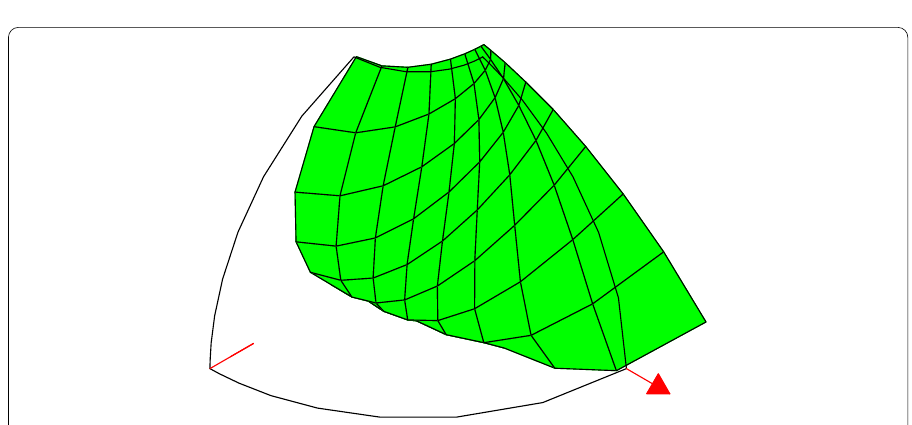
Fig. 11 Hemispherical shell: deformed distorted 8 × 8 mesh for P = 400